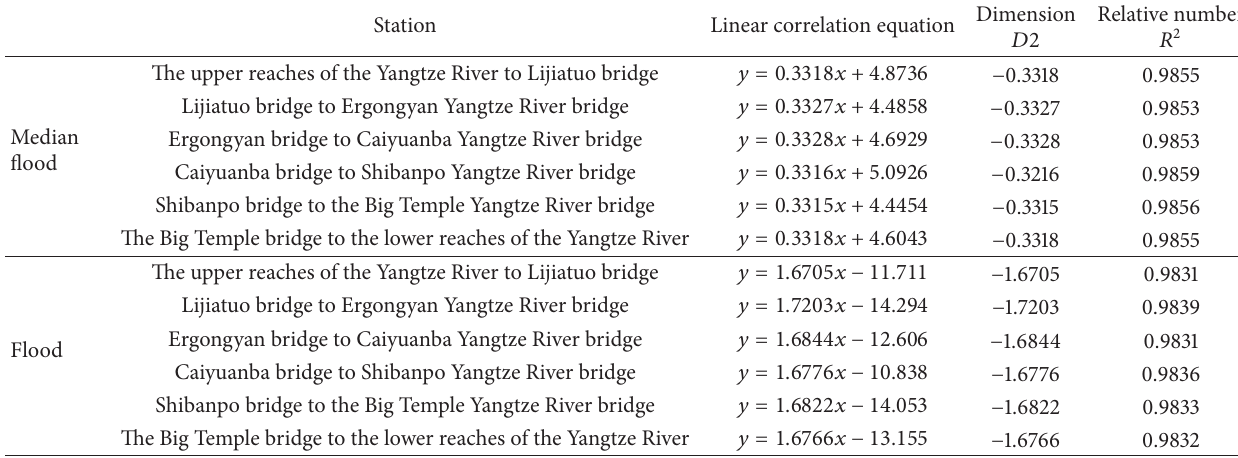
Table 5: The result of second-order accumulated variable-dimensional fractal sequence of Chongqing city of Yangtze River left bank.